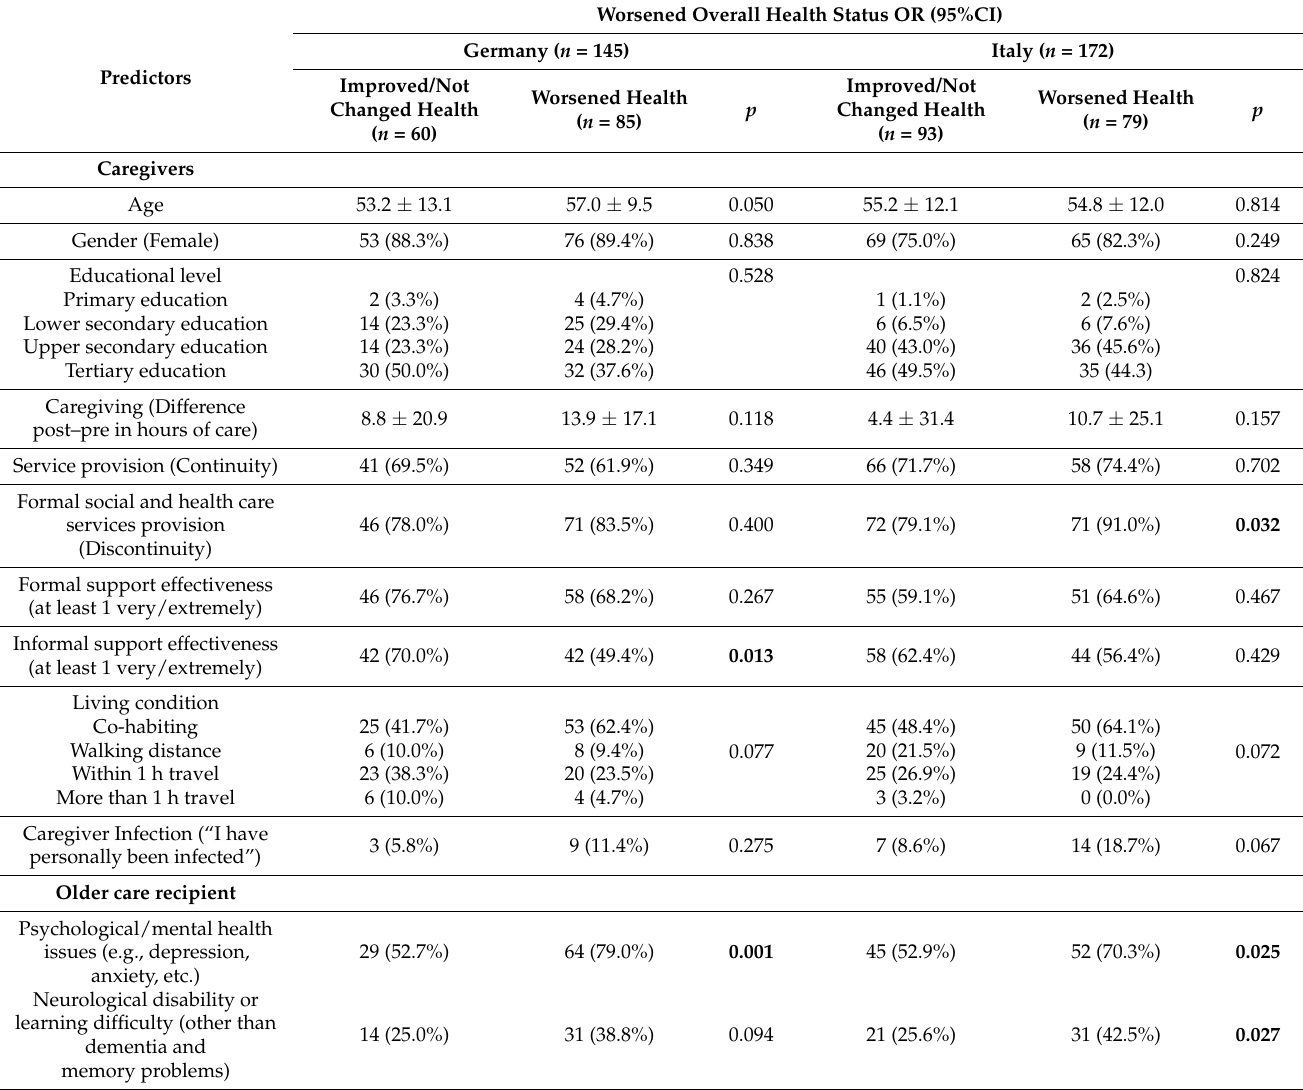
Table 5. Overall informal caregivers’ perceived health status and worsening predictors by